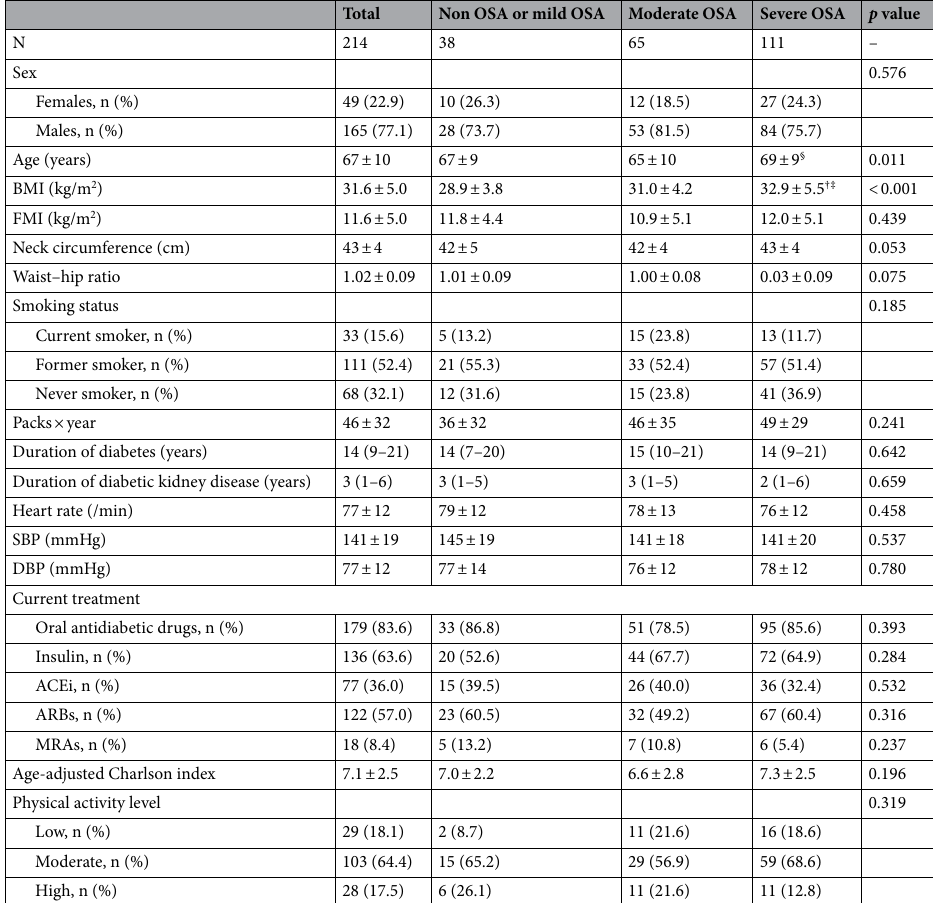
Table 1. Comparison of general characteristics between patients with diabetic kidney disease according to obstructive sleep apnea. Values are number (percentage), median (interquartile range [IQR]) or mean ± SD, according their characteristics and distribution. Comparisons were performed by chi-squared test, Kruskal– Wallis test or ANOVA with post-hoc comparisons by Bonferroni test: † p < 0.001 vs. non-OSA or mild